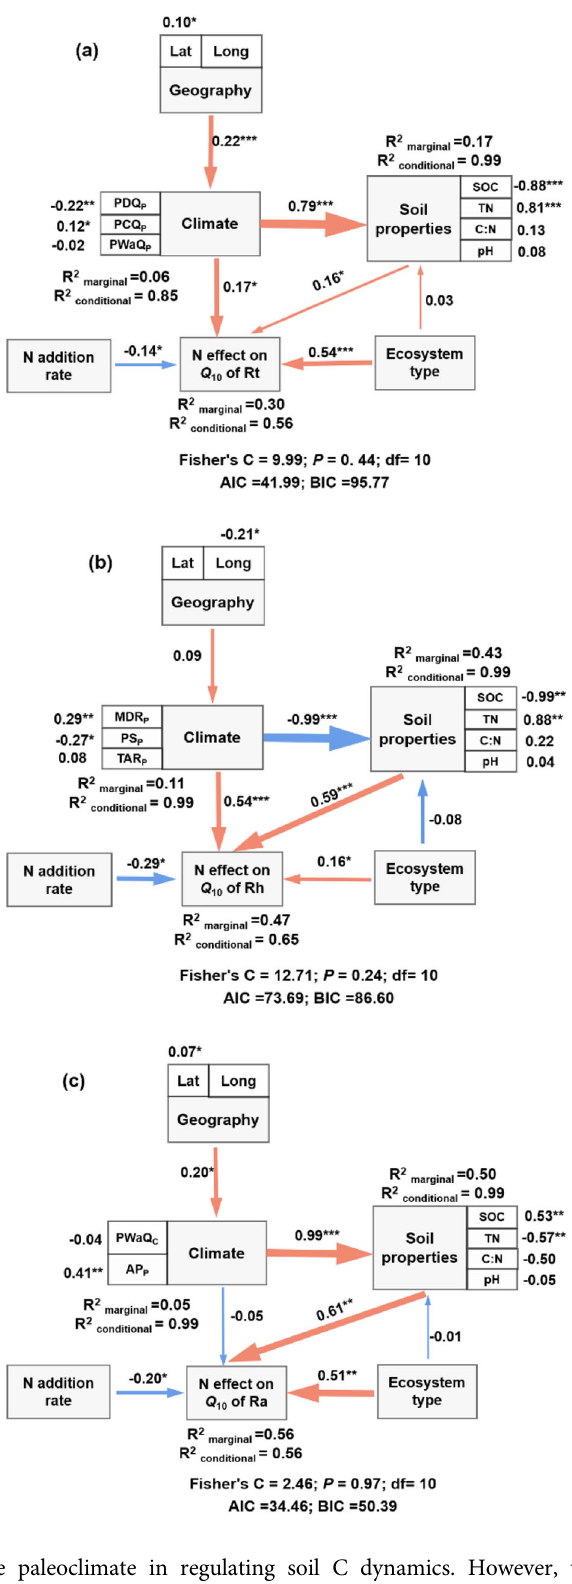
Fig. 6 Pathways of environmental and anthropogenic factors impacting the in fl uence of nitrogen enrichment on the temperature sensitivity